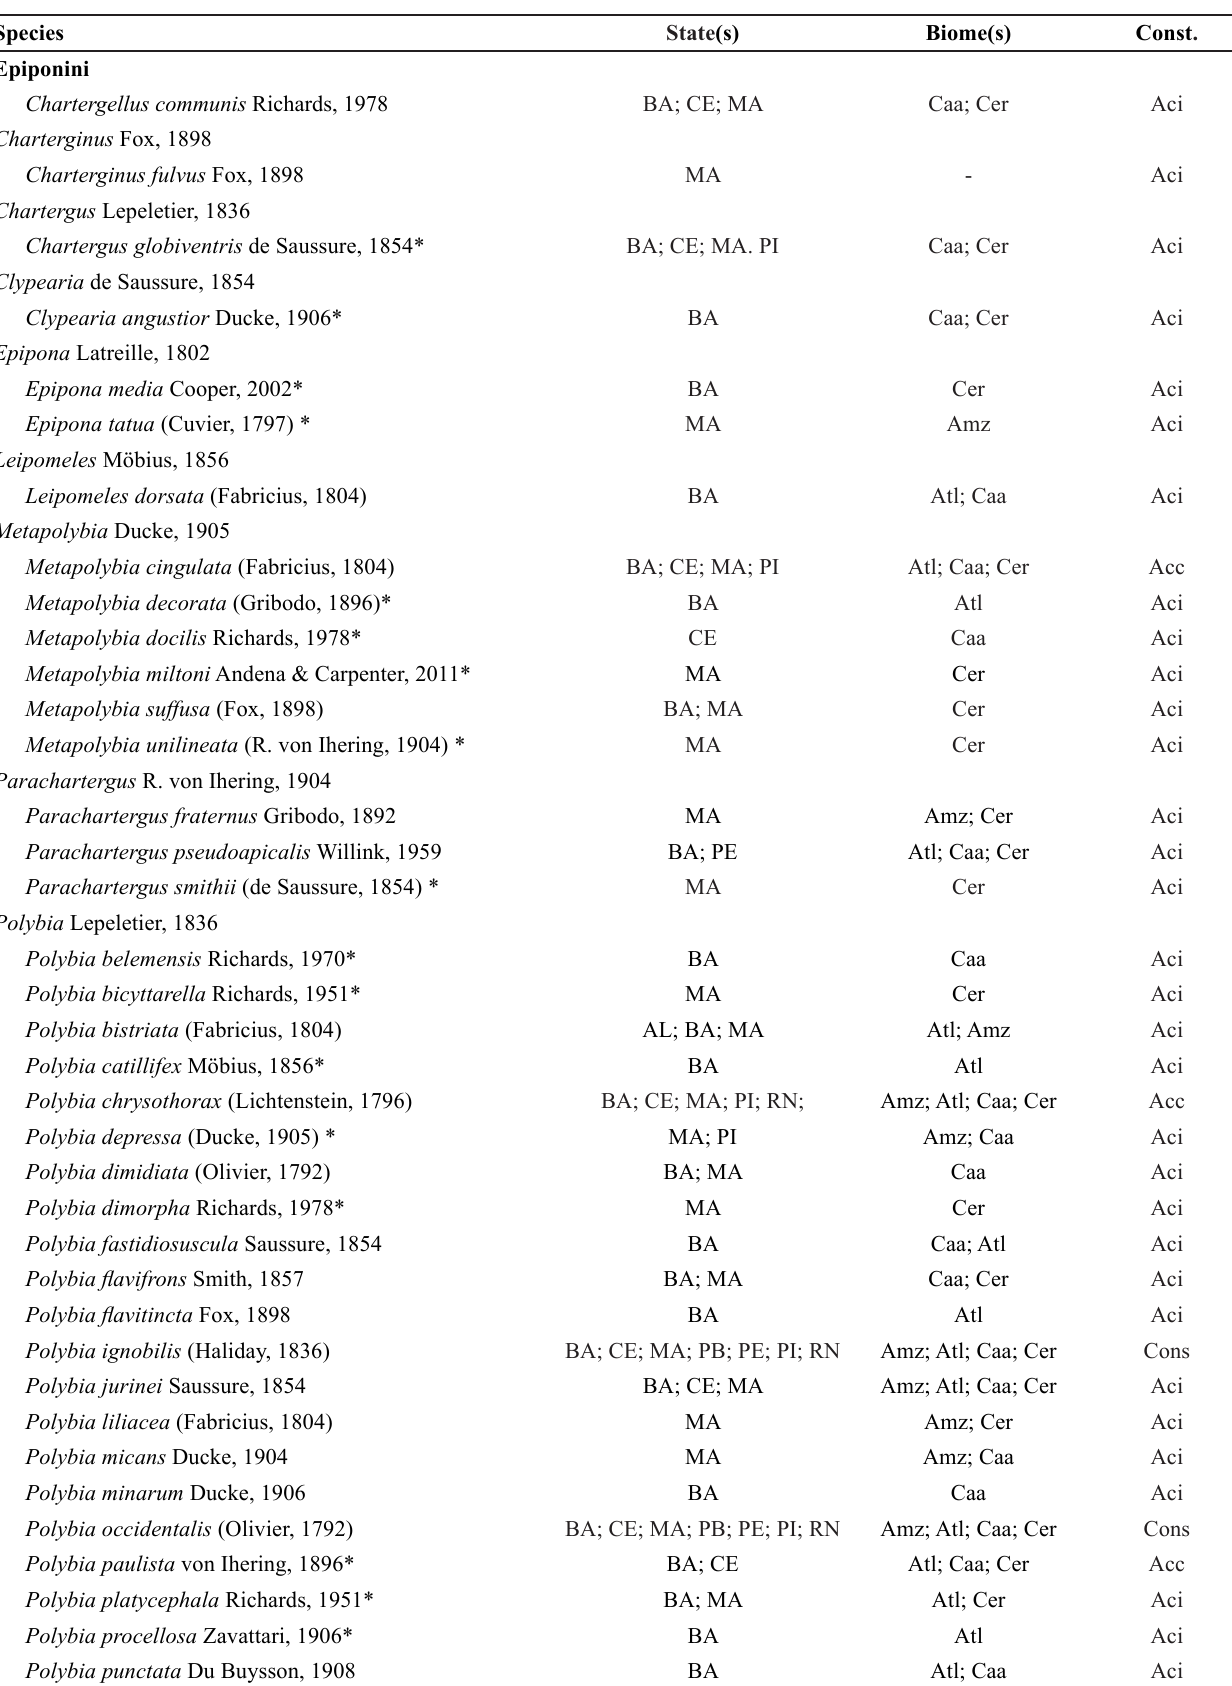
Table 2 . Species of Social Wasps registered in Northeastern Brazil. States: AL: Alagoas; BA: Bahia; CE: Ceará; MA: Maranhão, PB: Paraí- ba; PE: Pernambuco; PI: Piauí; RN: Rio Grande do Norte. Biomes: Atl: Atlantic Forest; Amz: Amazon Forest; Caa: Caatinga; Cer: Cerrado. Constance: Acc: Accessory; Aci: Accidental; Cons: Constant. *New species records after Richards (1978). (Continuation)